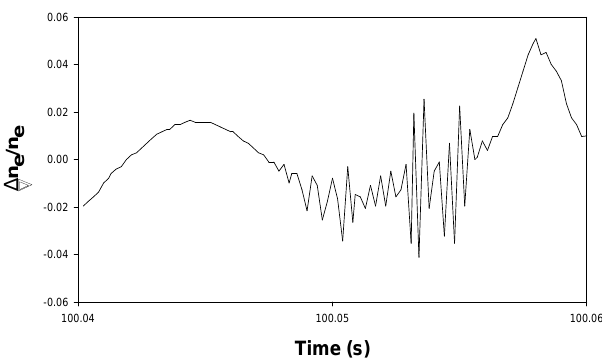
Fig. 2. Telemetry record of the plasma waves obtained at 105km altitude on 20 November 1999 when the meteor activity level is one-third in comparison to the first